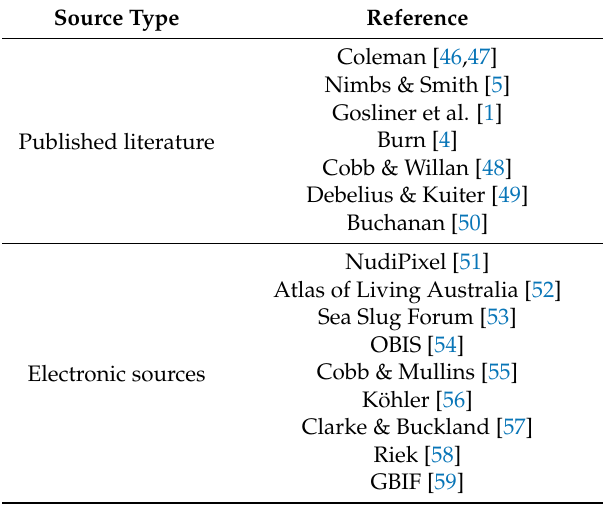
Table 1. Summary of source documents for global distribution